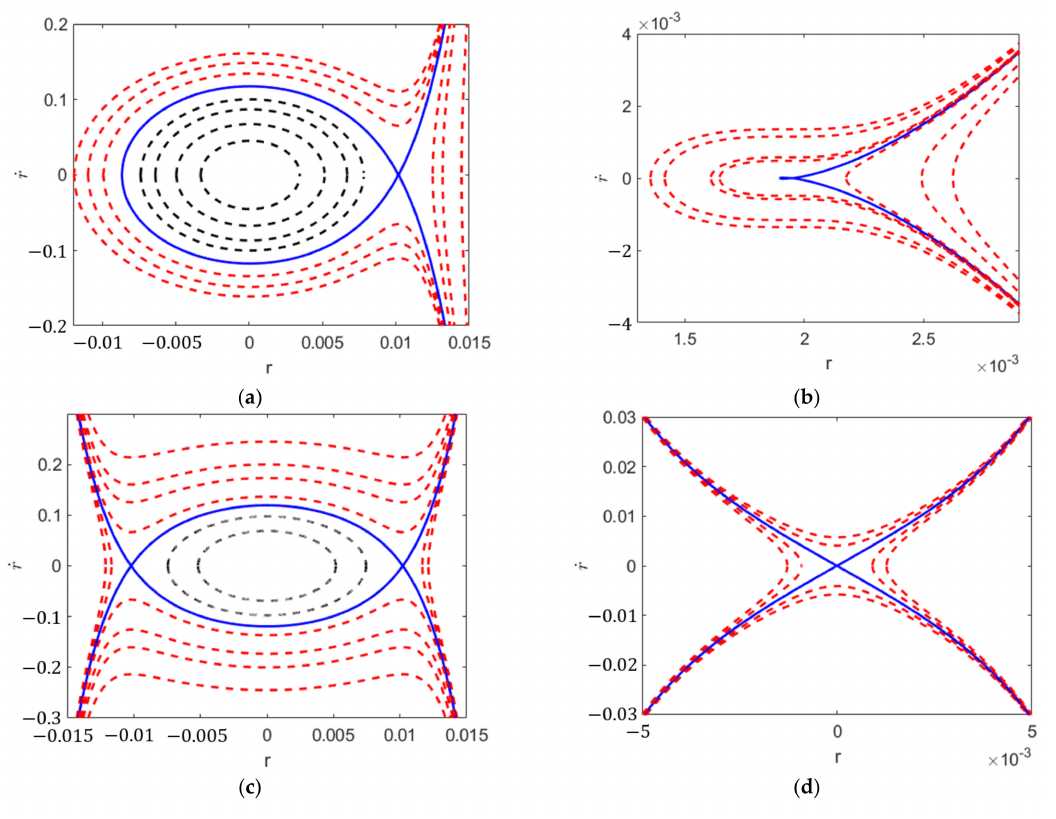
Figure 9. Phase portraits for a single magnet case ( a , b ) and double magnet case ( c , d ) for a gap size of